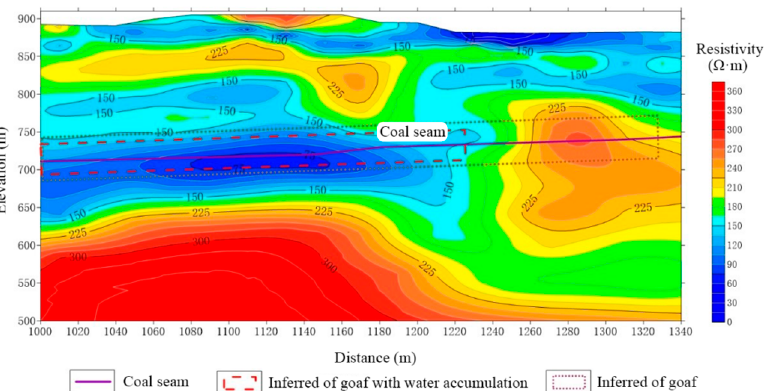
Figure 8. Apparent Resistivity Cross-Sectional Diagram of Survey Line L10 Obtained Through CSAMT-based 2D Profile Inversion.